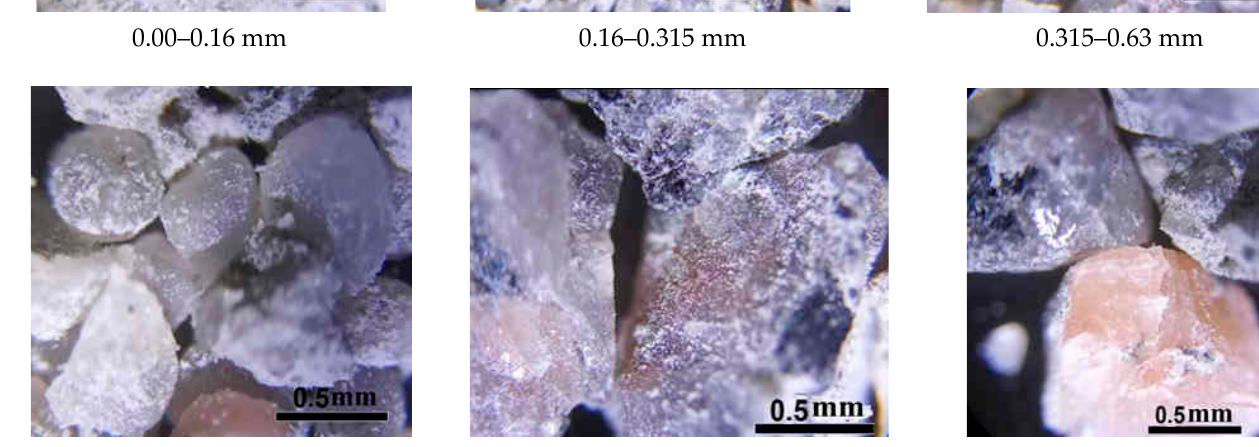
Figure 3. Particles of concrete scrap of various fractions.